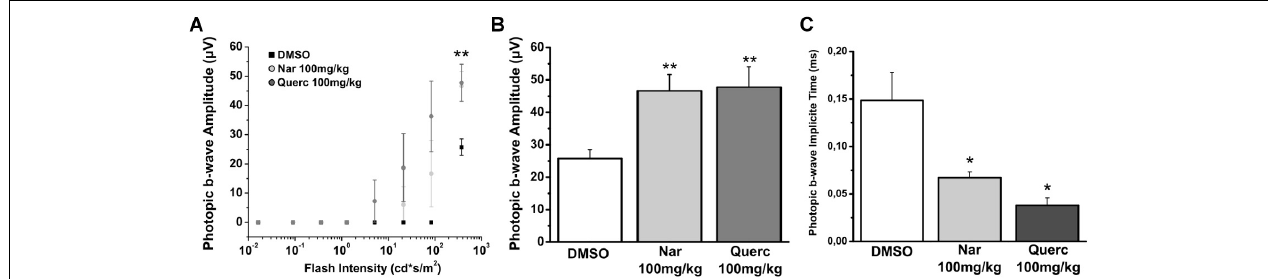
FIGURE 1 | Naringenin and quercetin slow down the decline of photoreceptor function in rd10 mice. Photopic ERGs were performed at P45. (A) Sensitive curve of amplitude of photopic ERG response in function of increase intensity of light stimulus. (B) Histograms represent the maximum b-wave amplitude in response to the brightest flash. The bars are expressed as average ± SEM. (C) Histograms represent the implicit time of the maximum amplitude in response to the brightest flash. The dots are expressed as average ± SEM. Statistical analysis is one-way ANOVA followed by Bonferroni’s multiple comparison test ( ∗ p ≤ 0.05; ∗∗ p ≤ 0.01). Number of animals for each treatment group is n = 6.